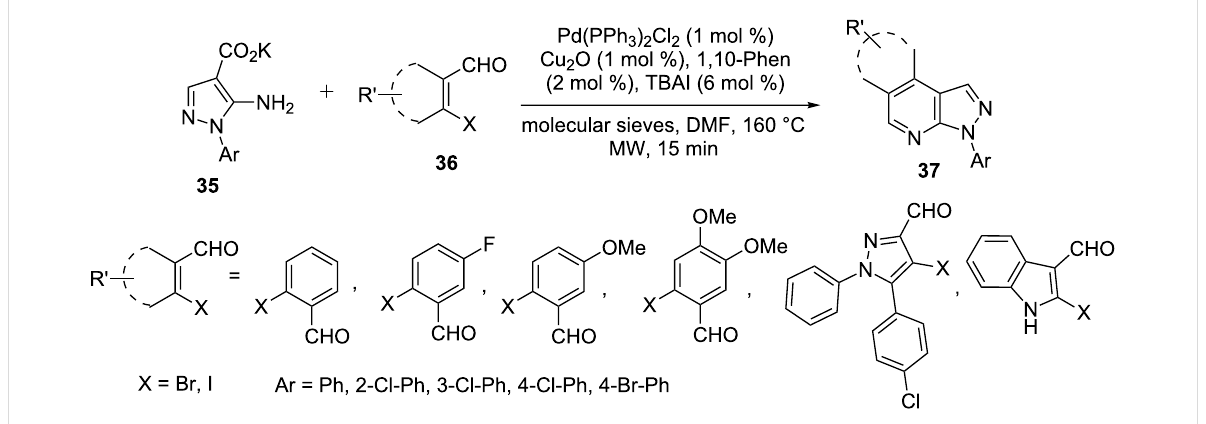
Scheme 6: Microwave-assisted palladium-catalyzed synthesis of pyrazolo[3,4- b